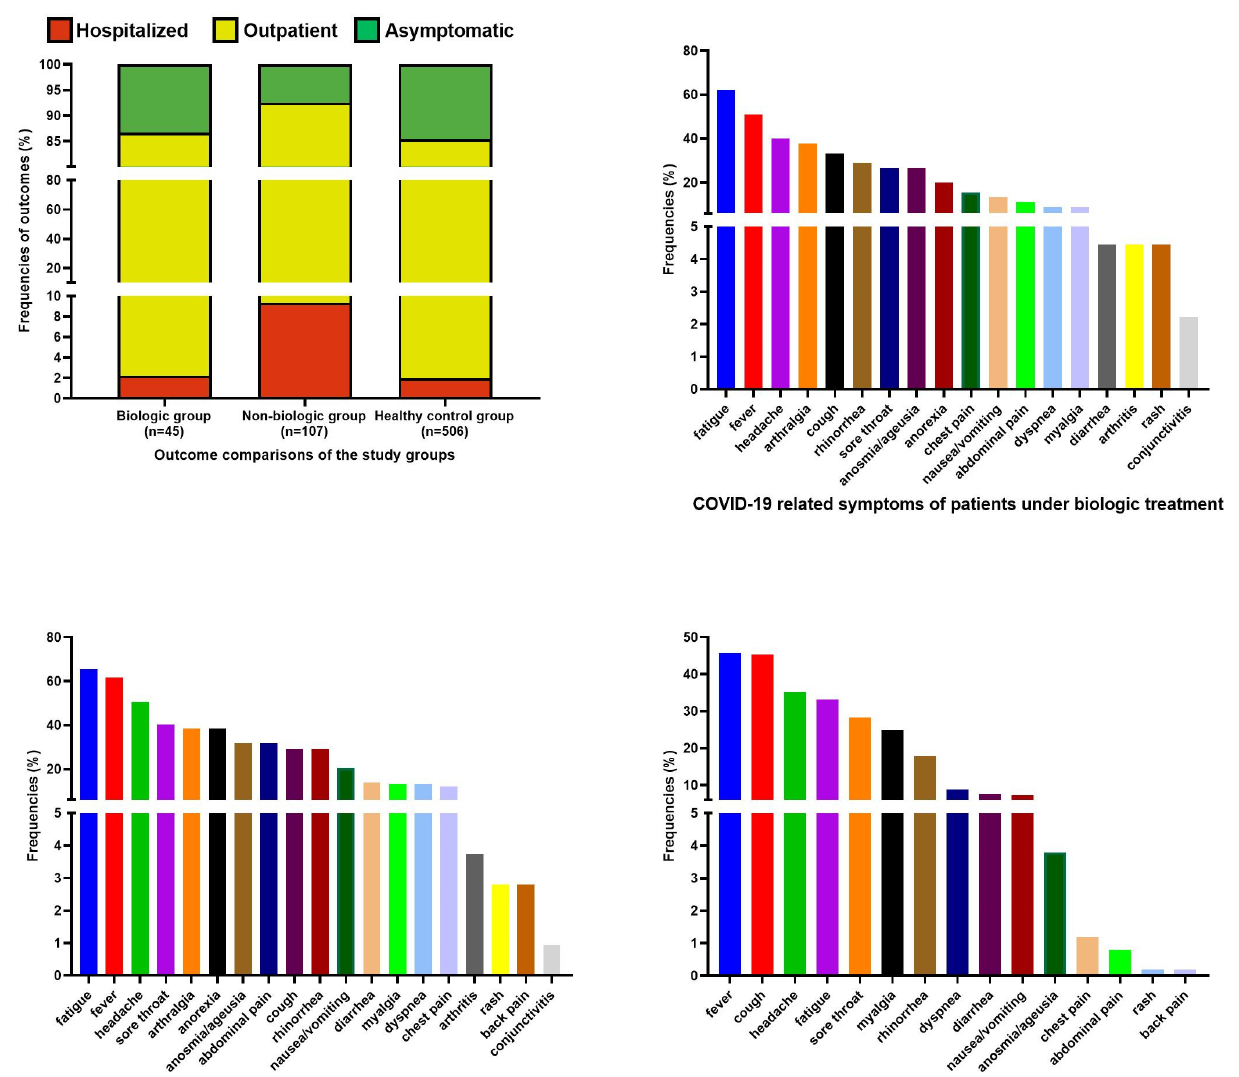
Figure 1. Outcome and clinical feature frequencies of the healthy control group, patients under biologic treatment, and patients not under biologic treatment.